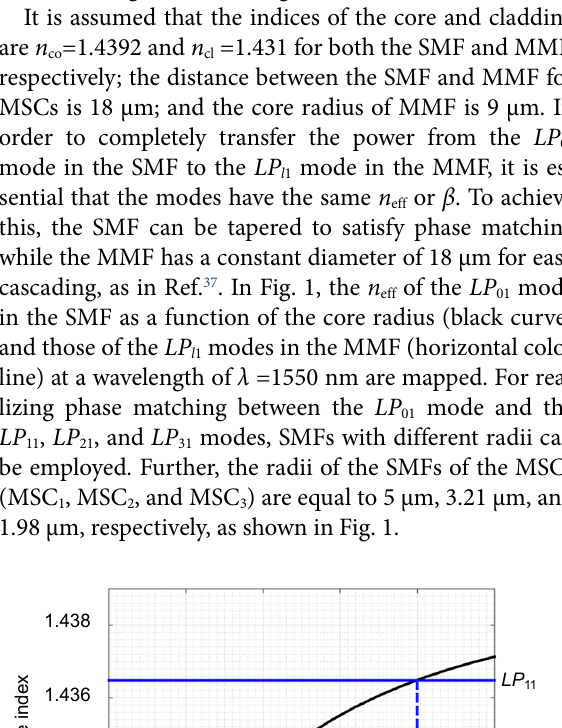
input mode is the fundamental mode LP 01 in the SMF,